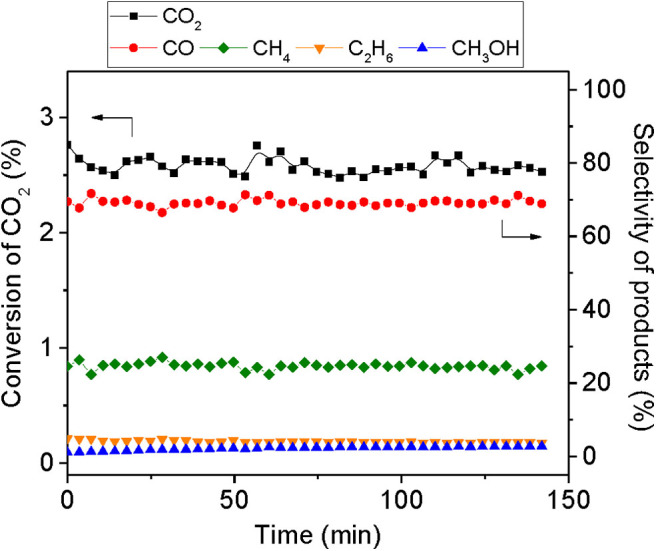
Temporal evolution of CO2 conversion and selectivity of products during the hydrogenation of CO2 over 400 mg of MoC/TiO2-P at 250°C and 20 bar total pressure, with a total flow rate of 30 ml min−1 of H2 /CO2/N2 with a H2:CO2 ratio of 5:1, 150 min on stream after stabilization of the temperature.